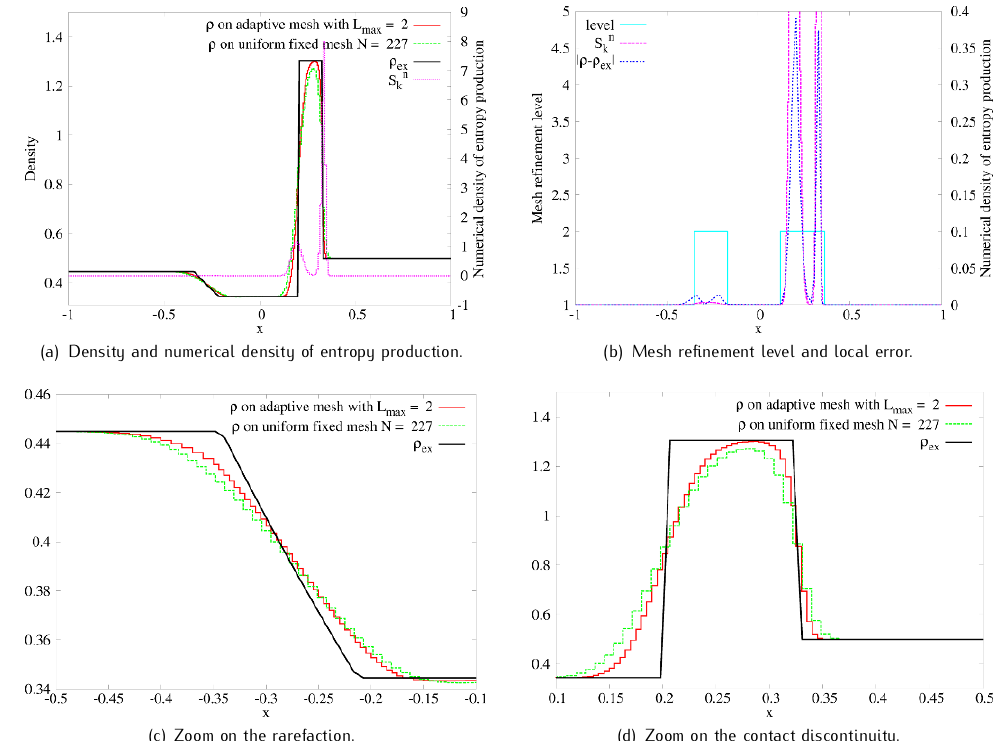
Figure 9. Lax’s shock tube problem: solution at time t = 0 . 13 using the AB1M scheme with L